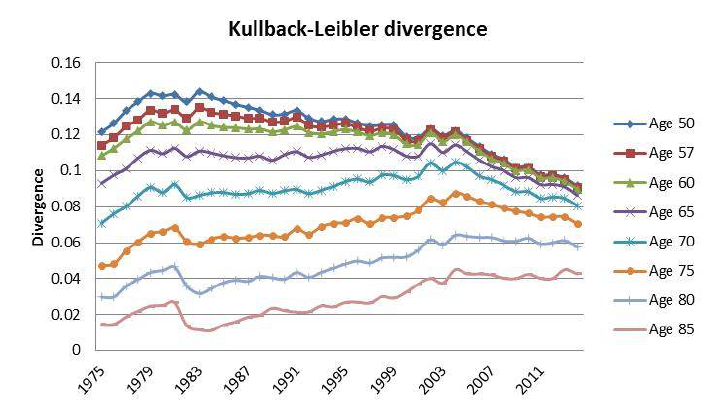
Figure 2. Kullback–Leibler divergence with respect to Z ξ at selected